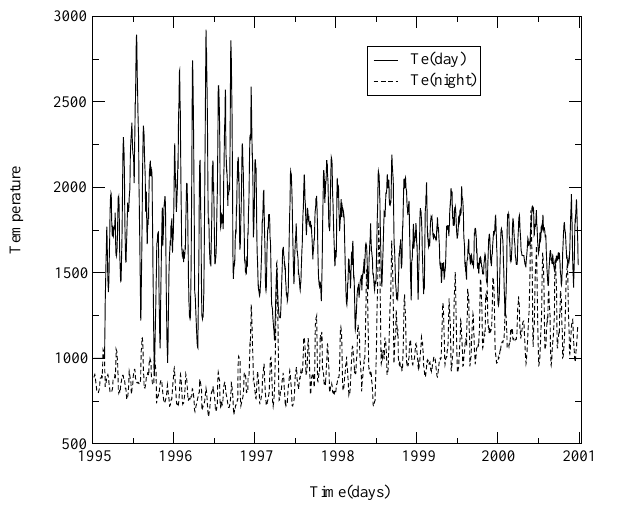
Fig. 1. Daytime (full line) and nighttime (dotted lines) average val- ues of electron temperature during 1995–2000.